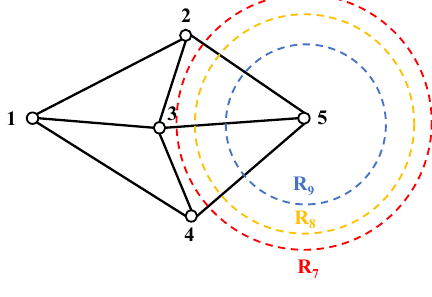
Fig. 11 The ripple spreading motion at t = 5